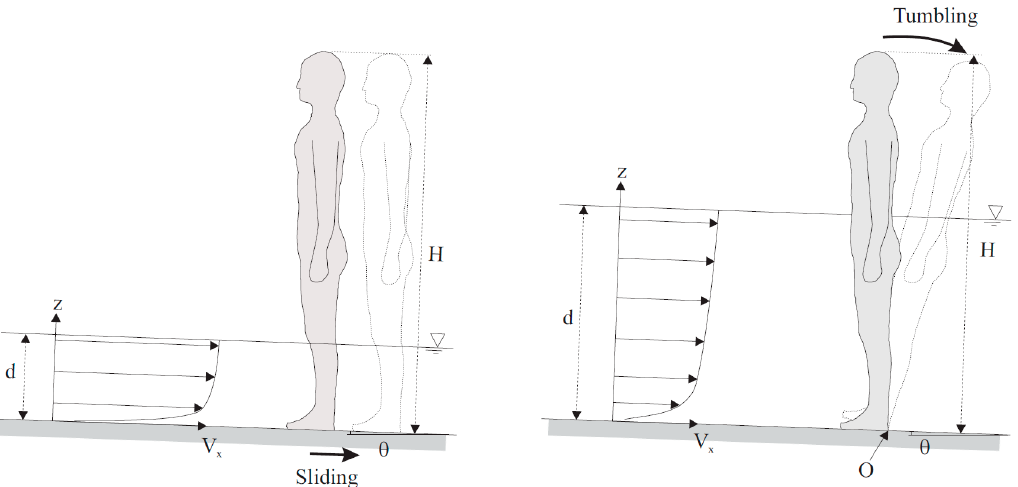
Figure 1. Definition sketch of forces acting on a stationary individual in floodwaters.